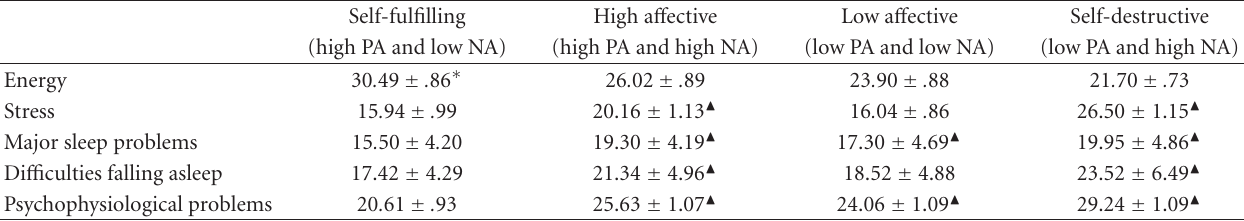
Table 2: Mean ( ± SD) scores for stress, energy, large sleep problems, di ffi culties falling asleep, and psychobiological problems among a ff ective profiles.